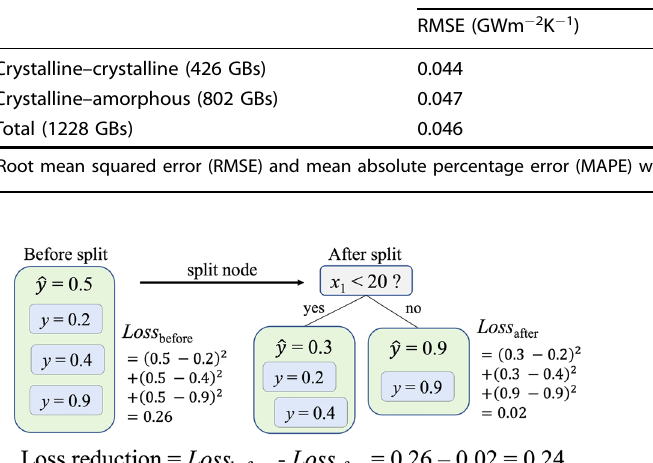
Fig. 4 Demonstration of computing loss reduction resulting from one split in a decision tree. This reduction value for a given feature is summed all over a single tree, then gets averaged over all trees. y , ^ y , and x 1 denote the target variable, predicted value, and selected feature for splitting, respectively.